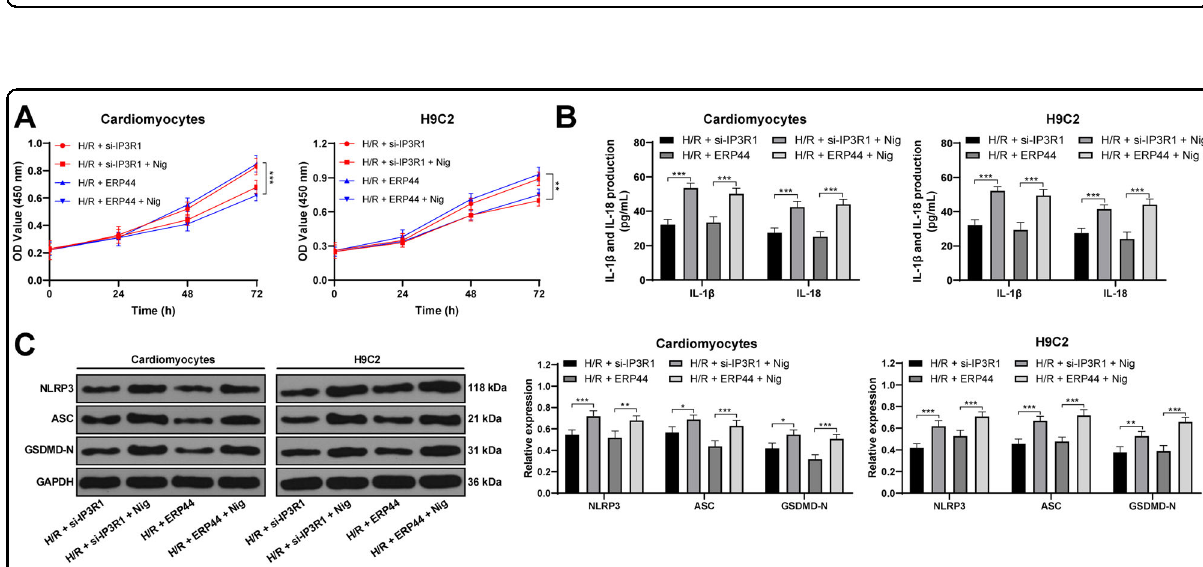
Fig. 5 Overexpression of ERP44 attenuates H/R-induced cardiomyocyte pyroptosis. A CCK-8 was used to detect cell viability; B colorimetric assay was used to detect Caspase-1 activity; C western blot was used to detect the levels of pyroptosis proteins; D ELISA was used to detect the levels of IL-1 β and IL-18. Nif represents calcium channel blocker Nifedipine D6. Compared to the H/R group, ** p < 0.01, *** p < 0.001. All experiments were performed three times independently. Data in panel B were analyzed using one-way ANOVA and data in panels A / C / D were analyzed using two-way ANOVA. Tukey ’ s multiple comparison test was applied for the post hoc test after ANOVA.